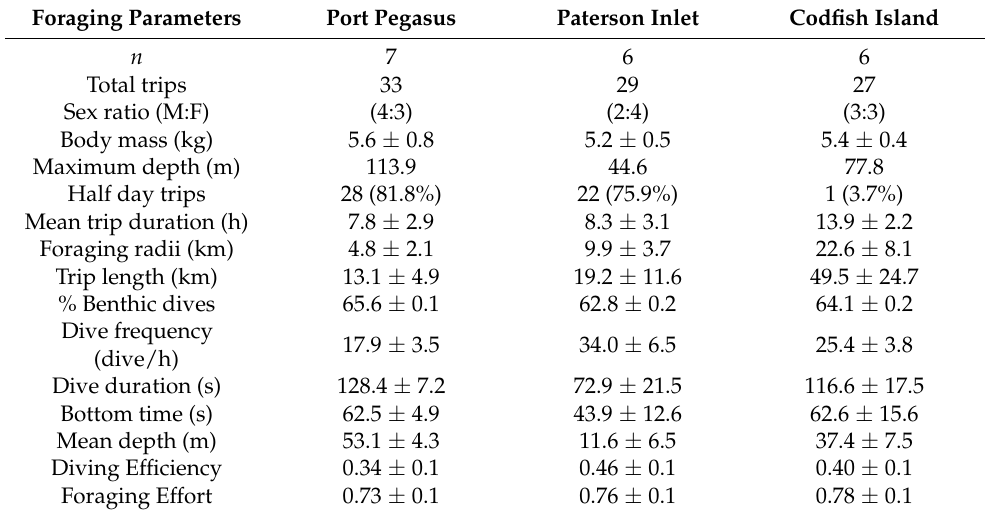
Table 1. Mean ± 1 SD parameters of breeding yellow-eyed penguins at Port Pegasus ( n = 7), Paterson Inlet ( n = 6), and Codfish Island ( n = 6) during the 2020/21 season. Foraging Parameters Port Pegasus Paterson Inlet Codfish